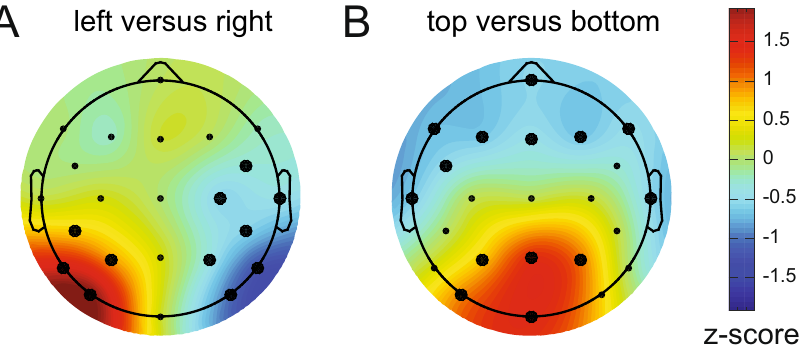
Figure 5. Activation patterns associated with peak decoding accuracy (240–250 ms) in Experiment 1. Derived from the product of the weight vectors and the covariance matrix (see Haufe et al . 11 ) normalized across space (see Methods). ( A ) The pattern associated with left versus right decoding. Note the clearly lateralized distribution. This lateralized pattern shows the distribution of neural activity underlying successful discrimination between targets appearing on the left and the right of fixation, and is equivalent to the mass- univariate difference between left and right targets. ( B ) The pattern associated with top versus bottom decoding, now showing a posterior-anterior distribution. Thick electrode dots belong to clusters having p < 0.05 under cluster based permutation testing, see main text for exact